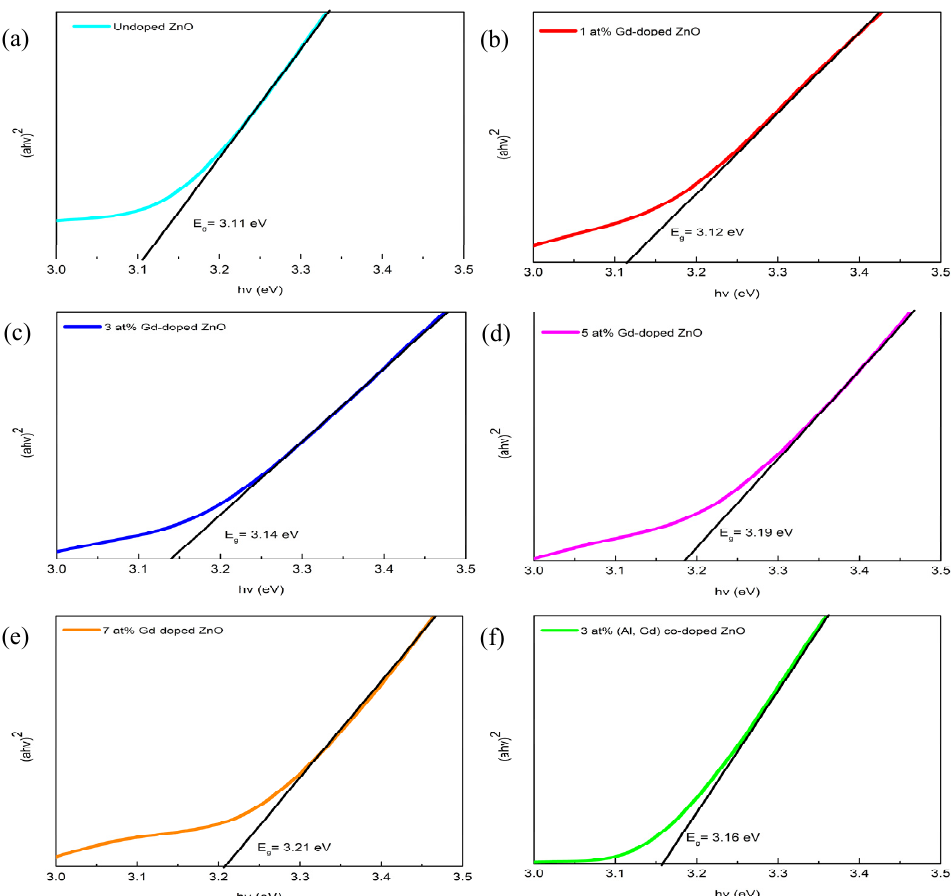
Figure 5. Graph of ( α h ν )2 versus h ν for ( a ) Undoped ZnO, ( b – e ) Gd ‐ doped ZnO films, and ( f ) 3 at% (Gd, Al) co ‐ doped ZnO films.